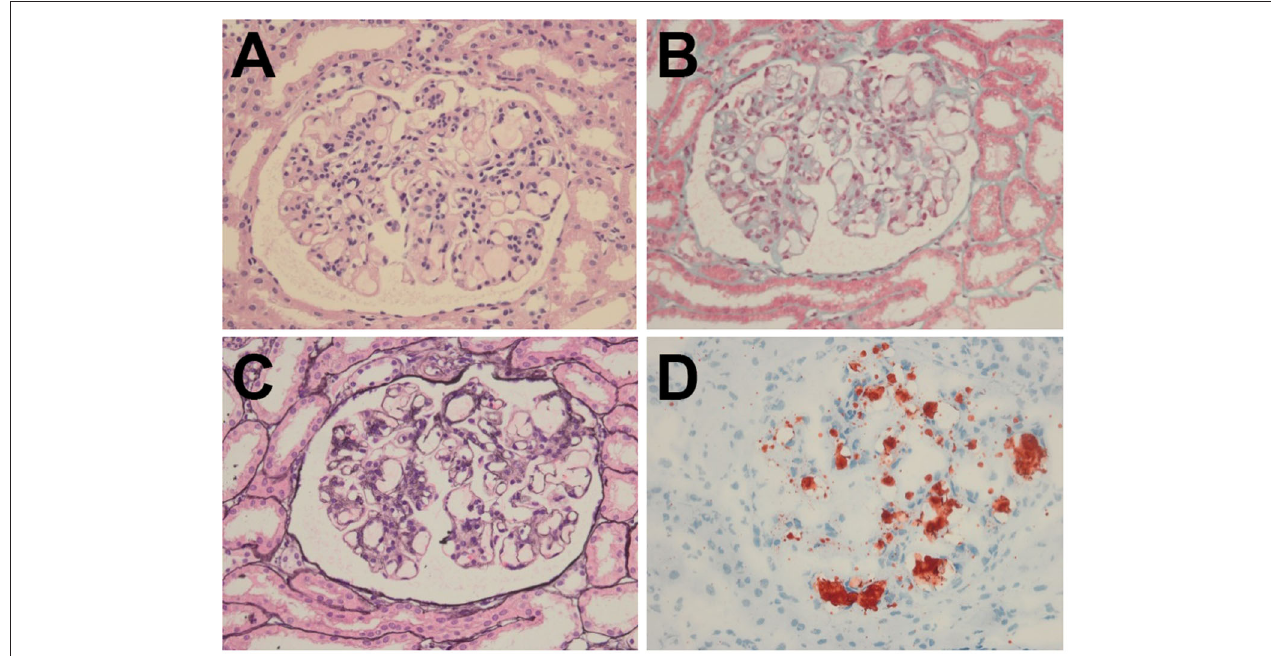
FIGURE 1 | Histopathology of the renal biopsy specimen. (A) H&E ( × 400) and (B) Masson ( × 400) staining showed segmental glomerulosclerosis with mild-to-moderate proliferation of the mesangial cells and matrix. (C) PASM ( × 400) staining revealed marked dilatation of the capillary lumina with lipoprotein thrombi. (D) Oil Red O ( × 400) staining confirmed the presence of intraluminal lipid droplets.